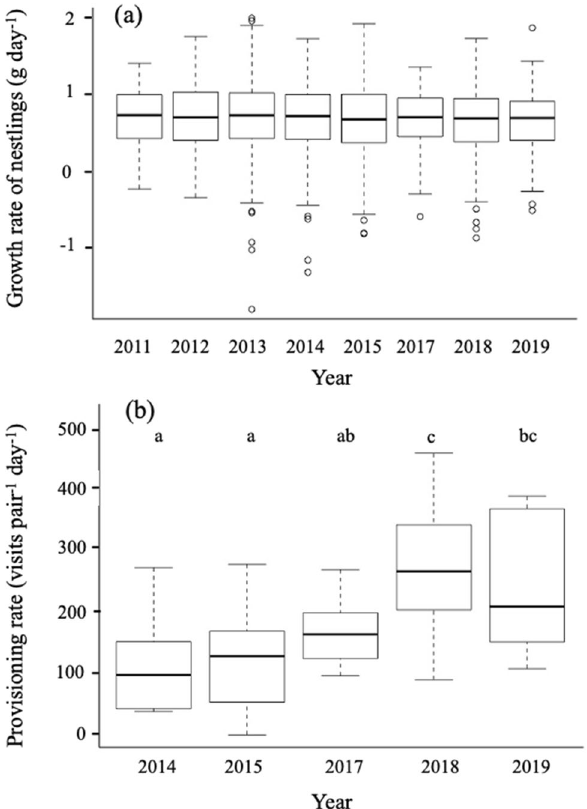
Figure 2. Yearly variation in nestling’s growth rate ( a ) and provisioning rate ( b ) in black-capped chickadees and boreal chickadees sampled at the FER Macpès, Rimouski, Canada (data combined for both species, see text). The dark line in boxes represents the median, the boxes show the interquartile range, the error bars represent minimum and maximum values and the points are extreme values. Data for yearly variation in nestling’s growth rate ( a ) included 858 nestlings from 173 broods. Of those, 98 broods were black-capped chickadees and 75 broods were boreal chickadees. Data for yearly variation in provisioning rate ( b ) included 73 broods. Of those, 39 broods were black-capped chickadees and 34 broods were boreal chickadees. Growth rate did not differ among years while provisioning rate was at its highest in 2018. Different letters in ( b ) indicate significant differences among